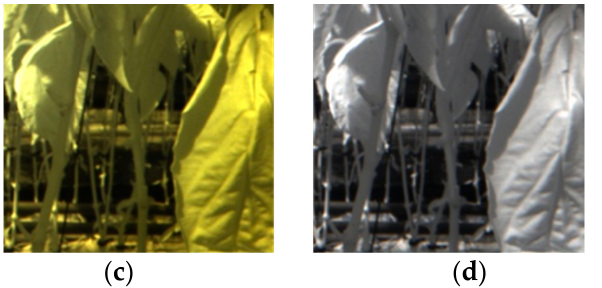
Figure 5. Spectrum images using band-pass filters of ( a ) visible spectrum, ( b ) 695, ( c ) 735, and ( d ) 800 nm.